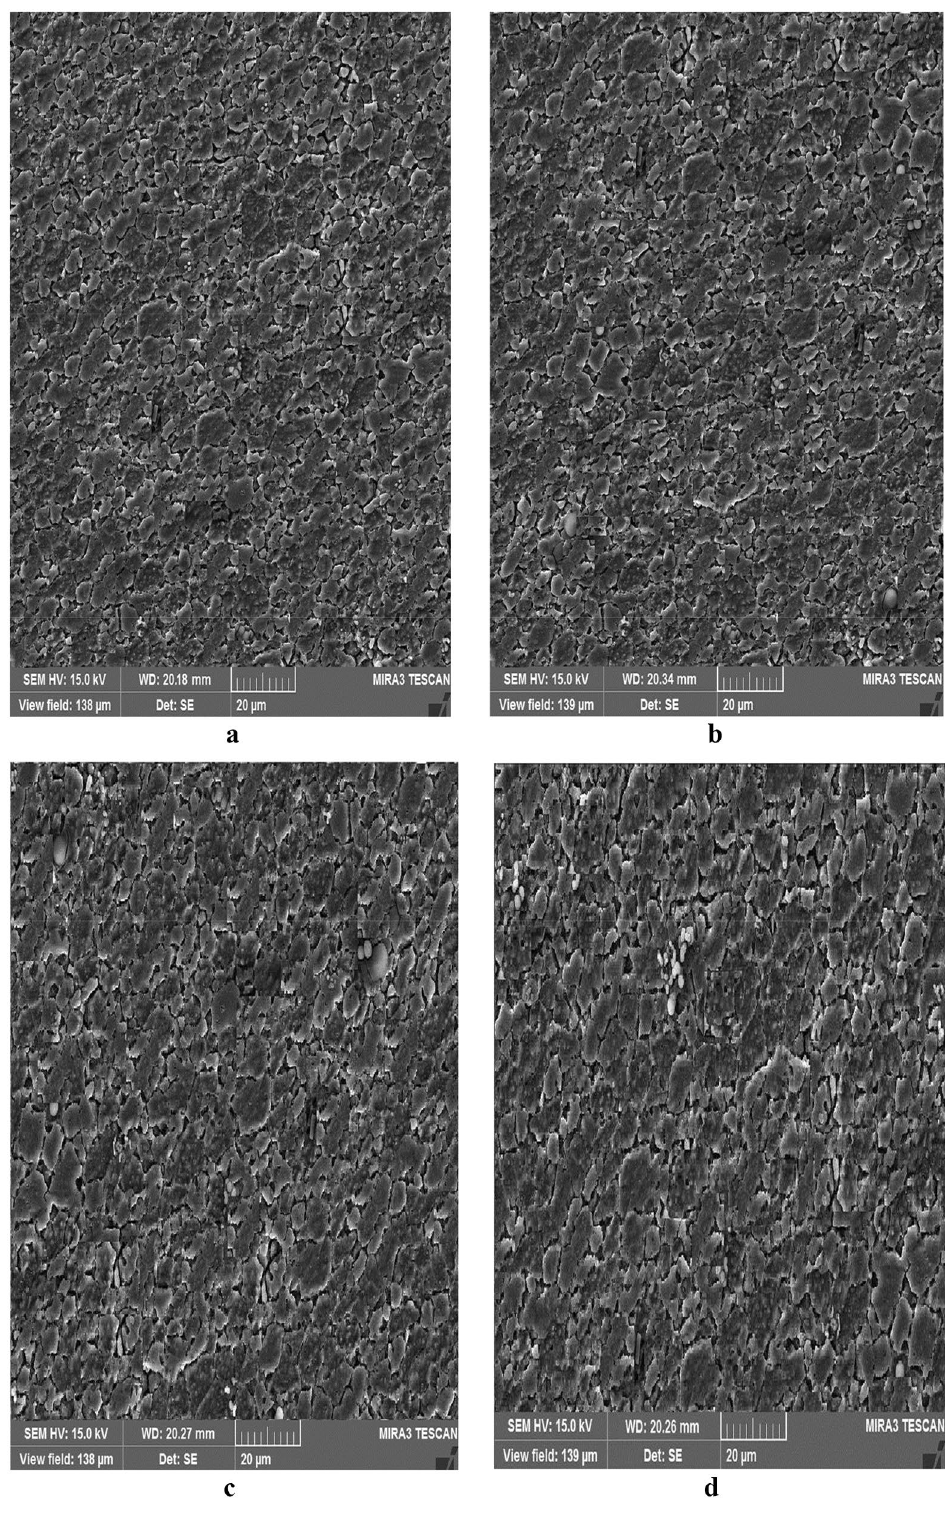
Figure 18. SEM images of the thermo-mechanically affected zone region of the samples: ( a ) threaded cylindrical pin, ( b ) conical pin, ( c ) b17, and ( d )